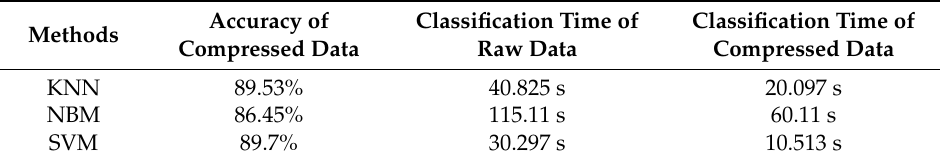
Table 2. Classification accuracy and training time variation chart for dimension reduction data.